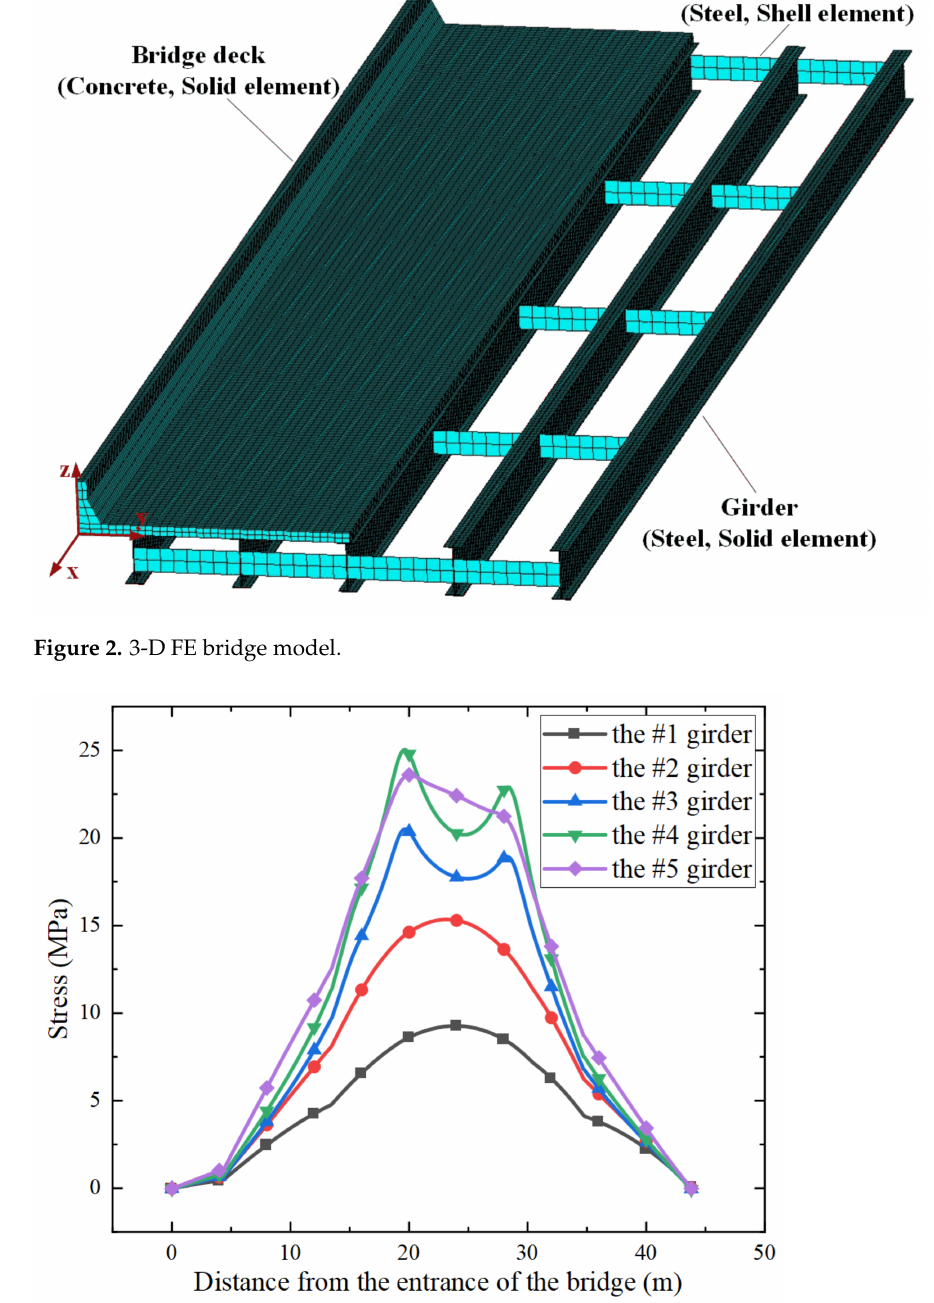
Figure 3. Stress histories at the weld between the bottom flange and web at the mid-span of the 1st girder to the 5th